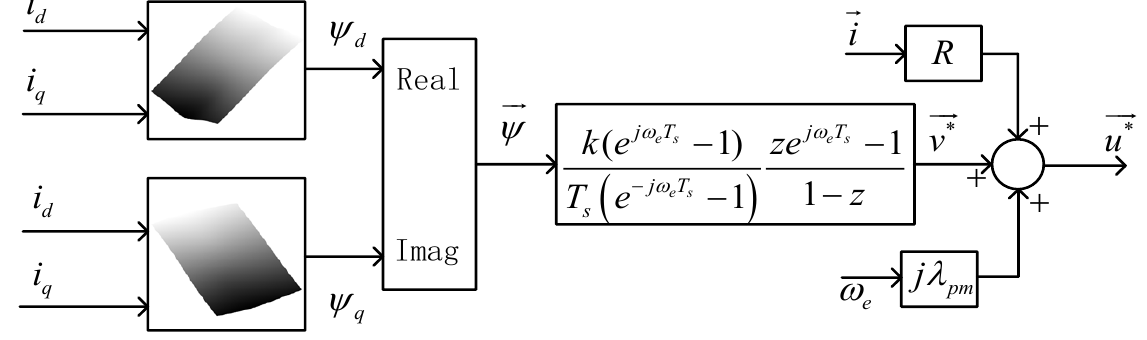
Figure 5. Structure of complex vector current controller based on the flux-linkage data.